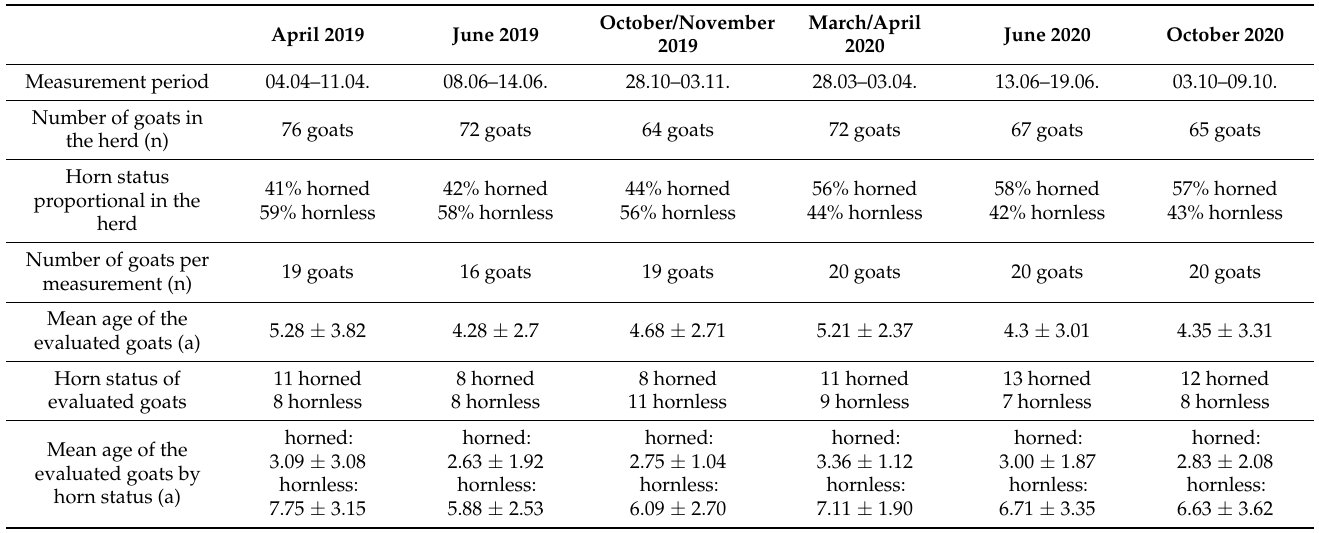
Table 1. Description of the different measurement periods with number of goats, age of the goats (mean ± SD) and horn status.